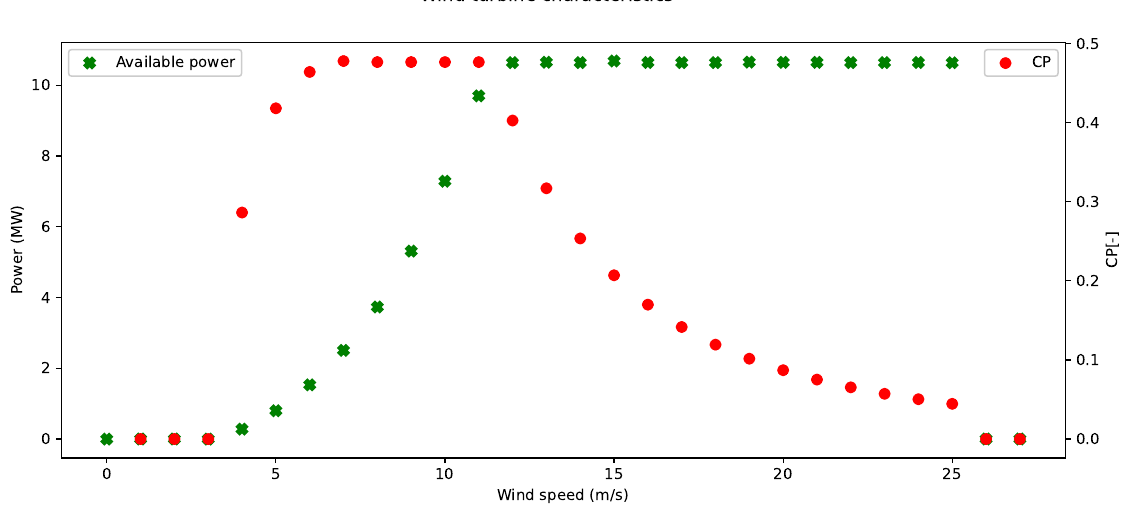
Figure 4. Characteristics of 10 MW DTU wind